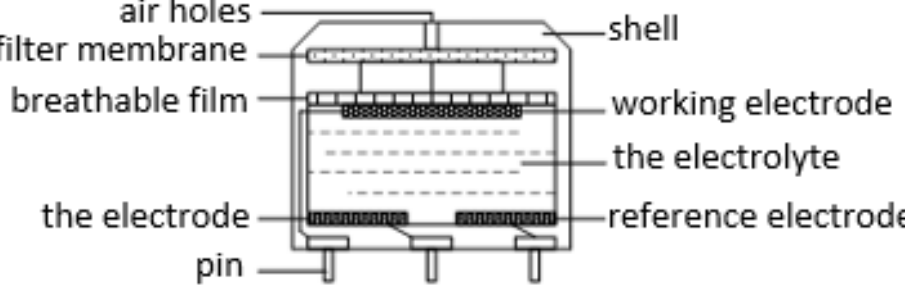
Figure 2. Three electrode electrochemical sensor structure.